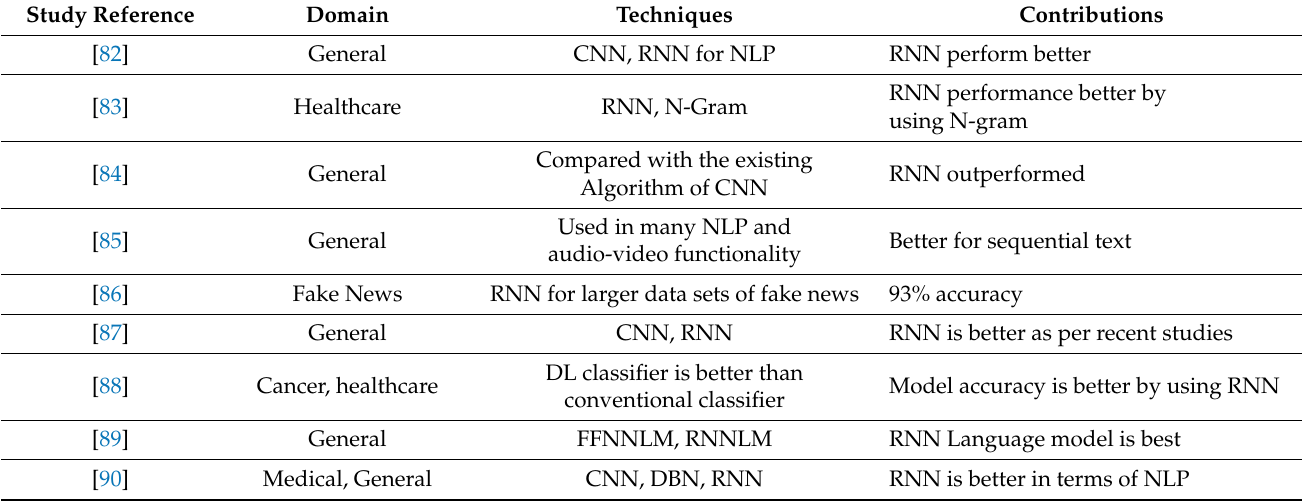
Table 9. Model Performance